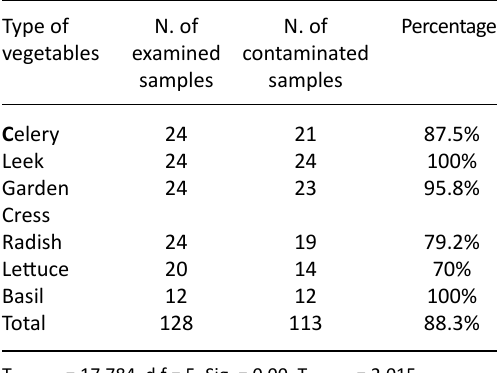
Table 2. Distribution of parasitic contamination rate on six type of fresh vegetables